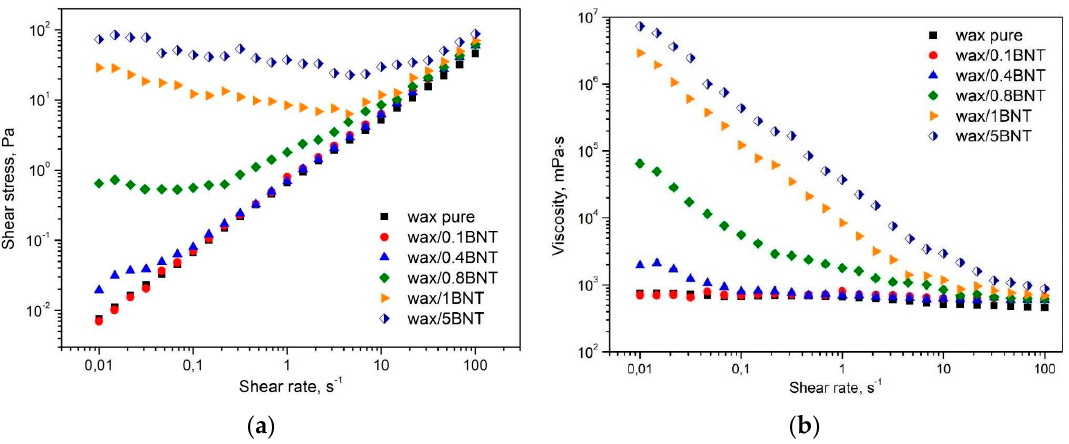
Figure 8. The flow ( a ) and viscosity curves ( b ) of pure PE-wax filled with various amounts of bentonite.